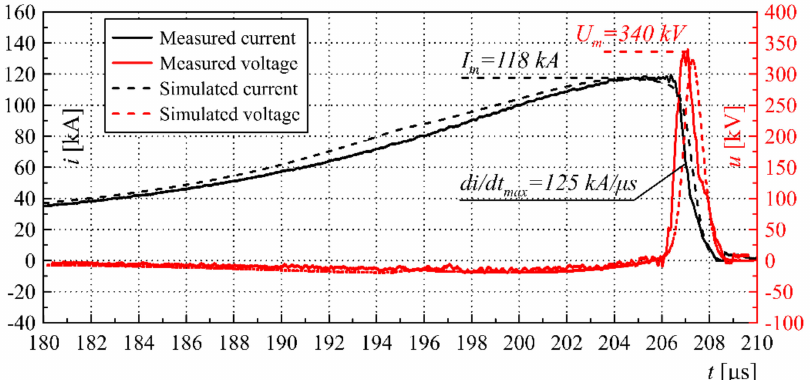
Figure 16. Examples of FCG and FF current (black) and voltage waveforms on the pulse forming coil (red) during the operation of the integrated high power pulse generation and forming system with characteristic values marked—comparison of simulation and experimental results: I m —generated current maximum value, U m —maximum formed overvoltage value, di / dt max —maximum current limitation